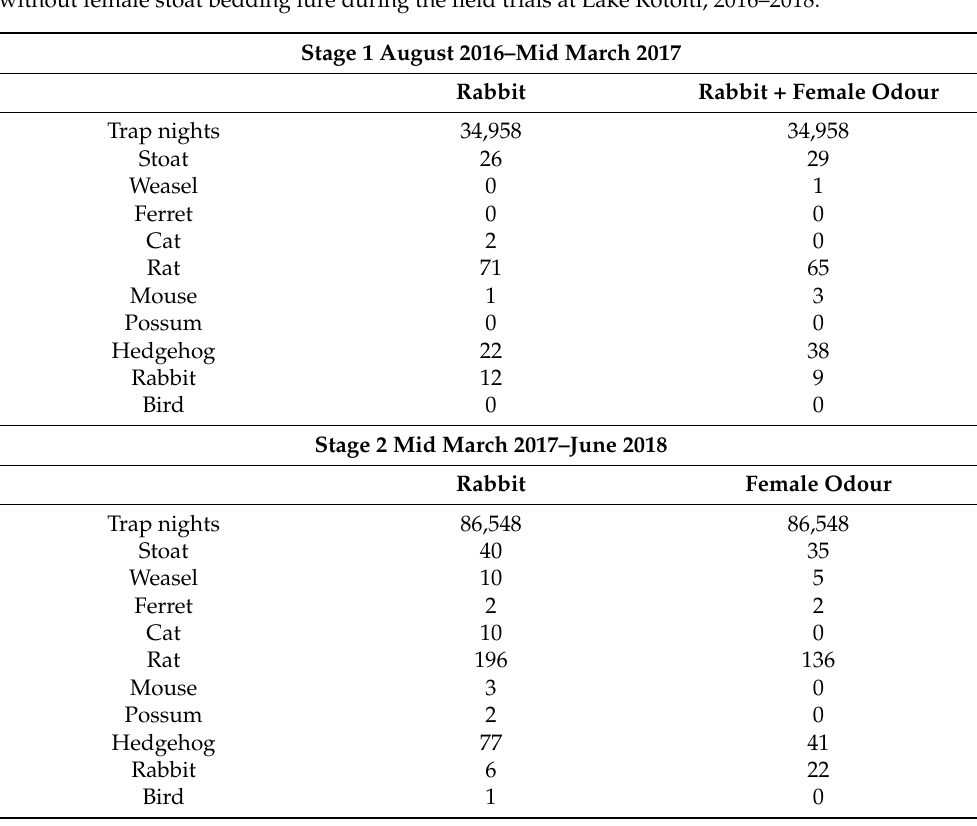
Table 4. Captures of stoats, other predators and non-target species on dried rabbit meat, with and without female stoat bedding lure during the field trials at Lake Rotoiti,